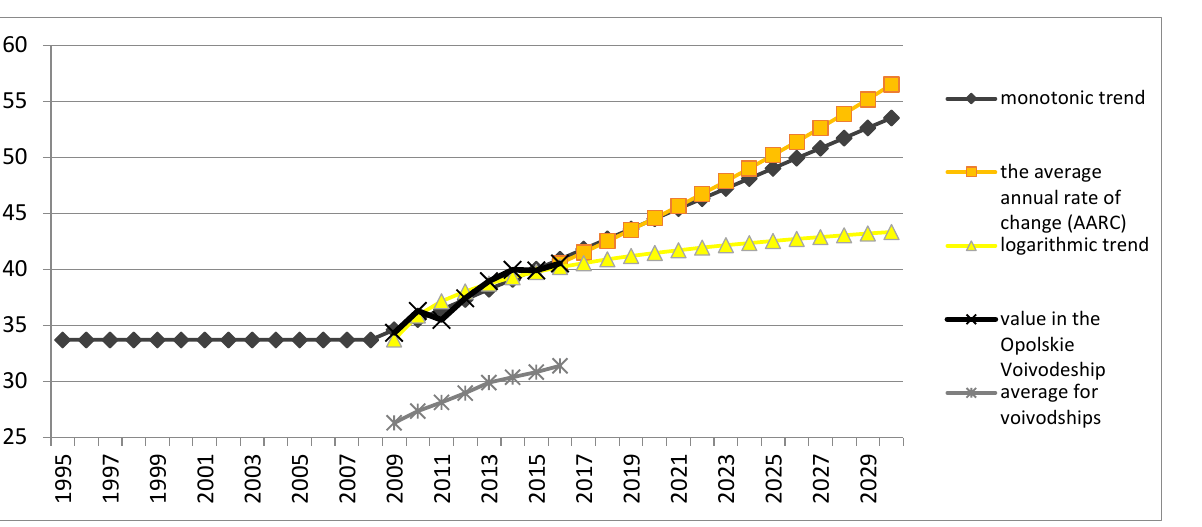
Figure 7. Share of surface areas subject to local spatial development plans in the total surface area (%). Source: own elaboration.